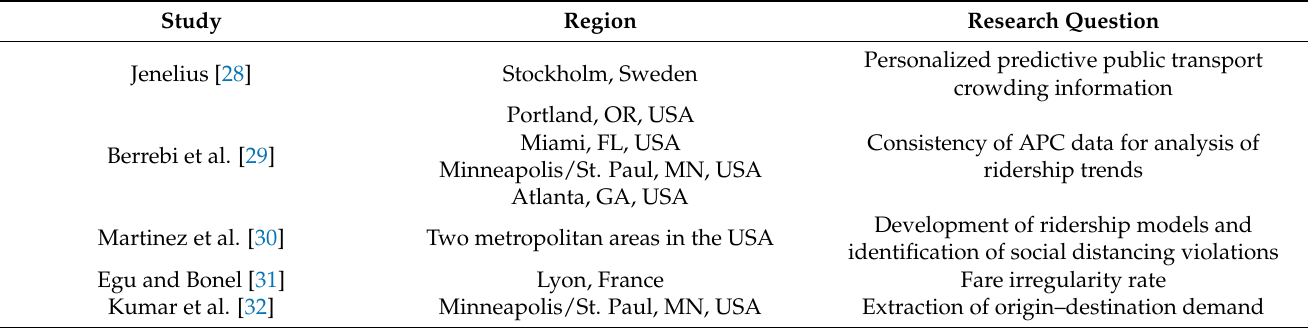
Table 1. Contribution of recent